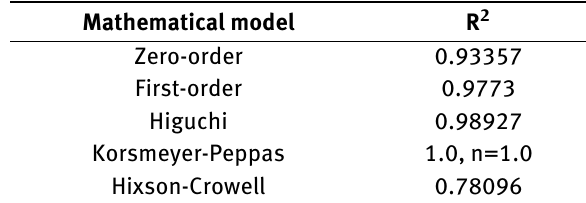
Table 1: Correlation Coeflcients (R 2 ) for linear relationship from different mathematical models of MNPSiO 2 -FA/Cis-Pt